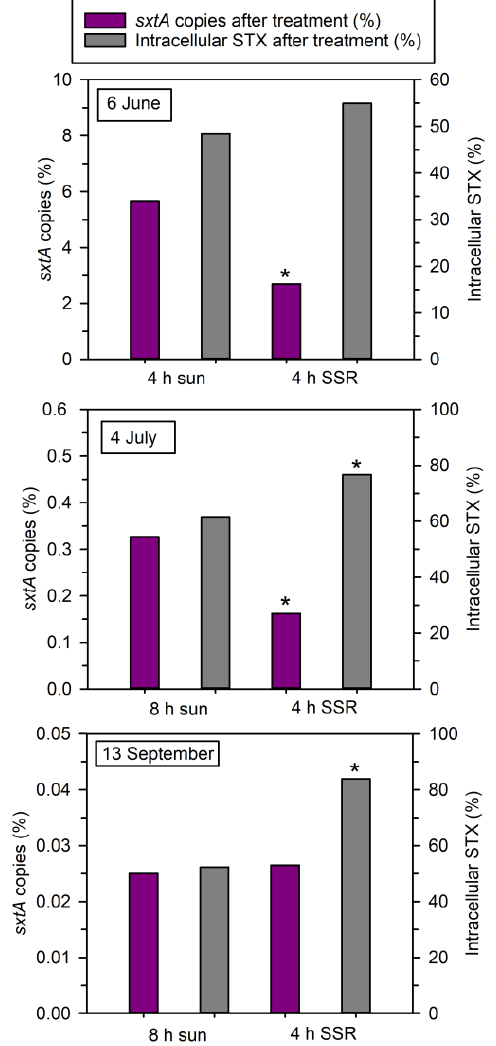
Figure 5. Effect of exposure by natural sunlight or simulated solar radiation (SSR) on sxtA copy numbers and intracellular STX concentrations in natural lake water. sxtA copies (left y axis) and STX concentrations (right y axis) remaining after end of the incubations are shown as % relative to untreated, natural lake water. Exposure time is indicated. Treatments being significantly different from natural lake water are indicated by * ( t -test, p < 0.05%). Quantification was conducted by ELISA technique. Means ± 1 STD are shown ( n = 3).